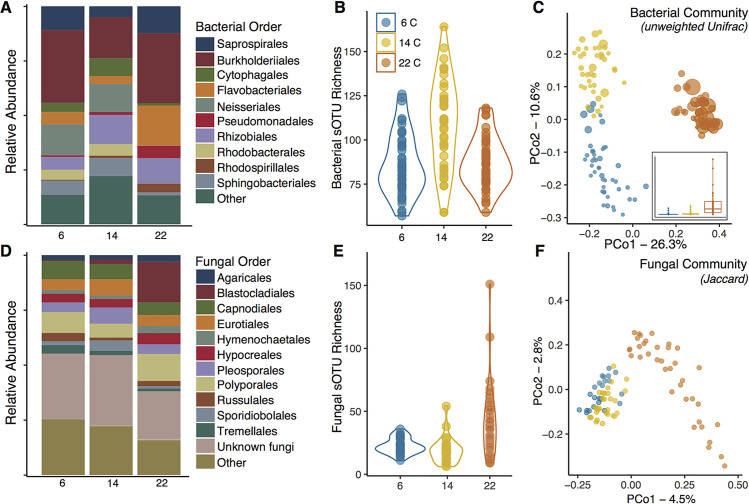
Skin microbiomes of adult Notophthalmus viridescens housed at three experimental temperatures.(A) Taxonomic composition of bacterial communities at the order level varied across temperatures; (B) sOTU richness of skin bacterial communities differed among temperatures; (C) Principal coordinates analysis (PCoA) of unweighted Unifrac distances showed differences in bacterial community composition between temperatures. Points are scaled by predicted Bsal-inhibitory function. Inset plot shows the same scaling factor (predicted Bsal-inhibitory function) across temperatures, with the horizontal lines denoting the median values. (D) Taxonomic composition of fungal communities at the order level varied across temperatures; (E) sOTU Richness of fungal communities differed among temperatures; (F) Principle coordinates analysis of binary Jaccard distances showed differences in fungal community composition between temperatures.